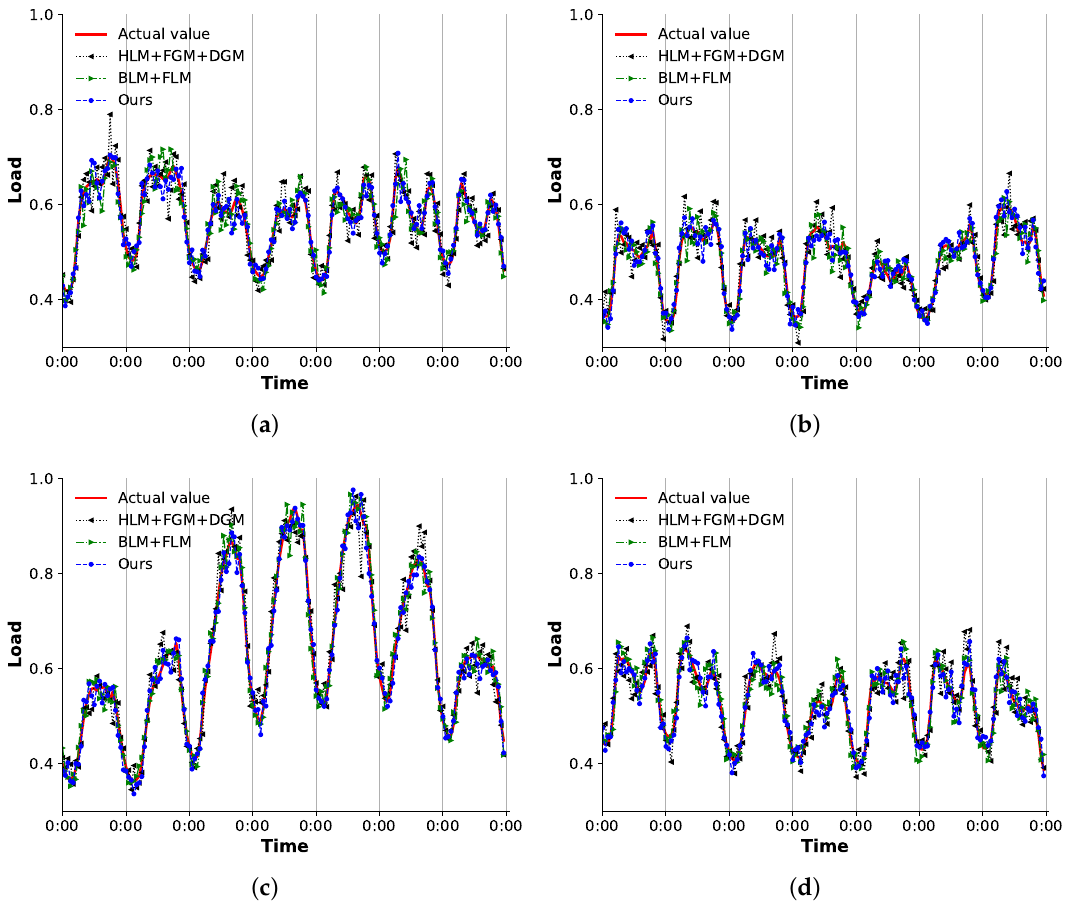
Figure 9. Forecast results for different input data patterns. The data are from the UGI in ( a ) February, ( b ) April, ( c ) August, and ( d ) October in 2018, and the results are not